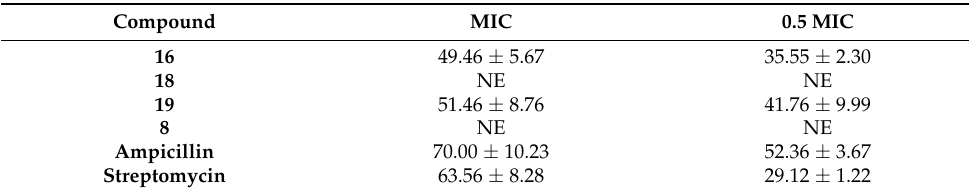
Table 5. Inhibition of P. aeruginosa biofilm formation